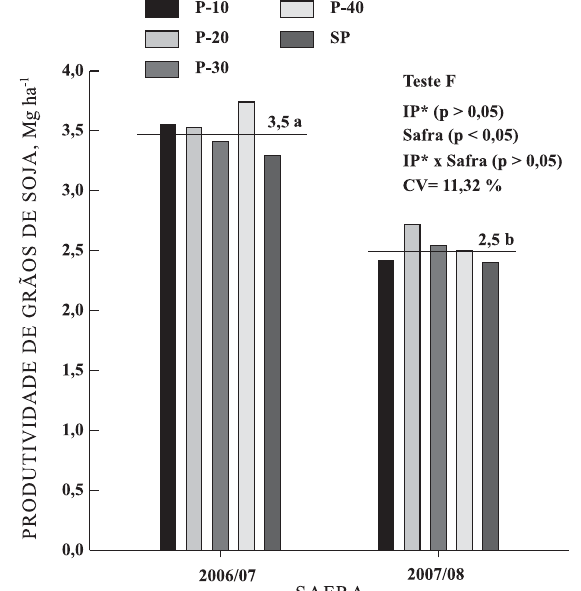
Figura 4. Pluviosidade ocorrida na Fazenda do Espinilho, no município de São Miguel das Missões – RS, nos meses de 2007 e parte de 2008. Dados obtidos com um pluviômetro de campo.